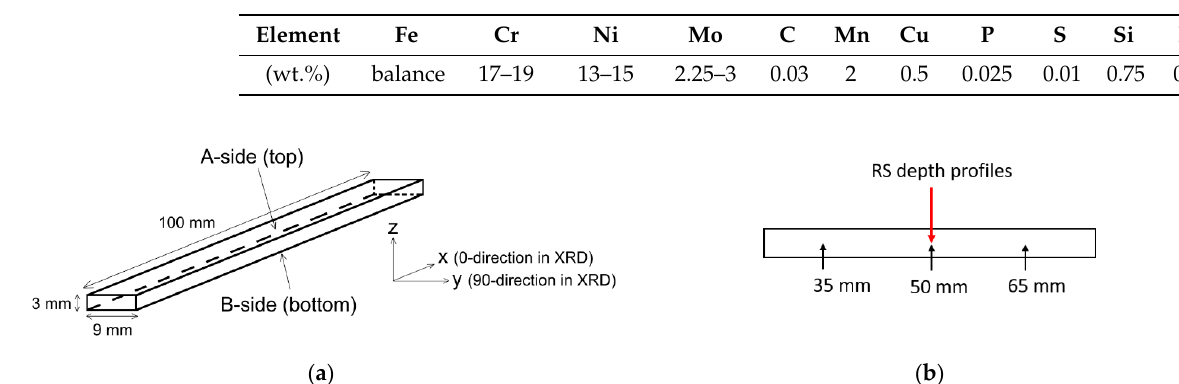
Table 1. Nominal chemical composition of studied 316L variant [33].